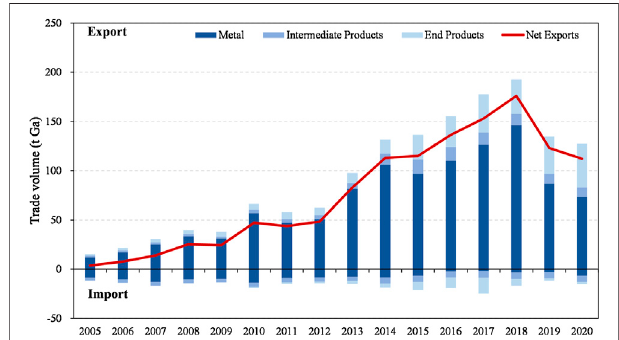
FIGURE 5 | Historical evolution of the trade volume of gallium in China between 2005 and 2020 (Data source: China Customs, UN Comtrade. Supplementary Table S4 contains the underlying data).